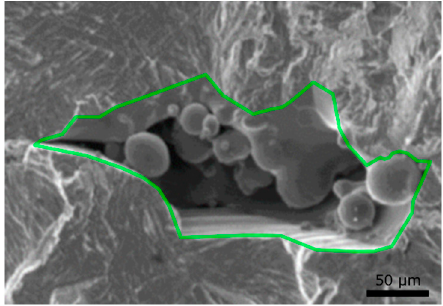
Figure 5. SEM image of the fatigue crack origin, a lack of fusion defect, in the SLM Ti-64, from [39] with its outline (in green) superimposed. Image Courtesy of Dr. Milan Brandt.